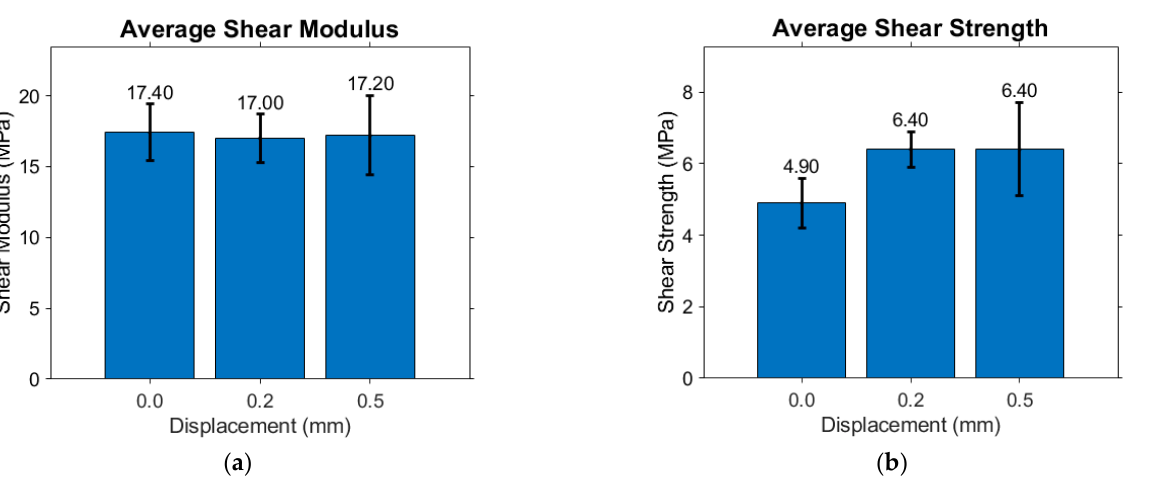
Figure 9. Specimens welded in displacement control with varying graphite coverage and resulting ( a ) average shear modulus and ( b ) shear strength. ( a ) average shear modulus and ( b ) shear